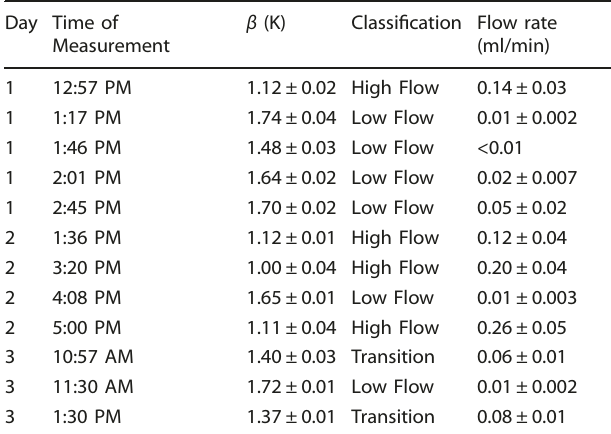
Table 1. Flow rates calculated for 12 spot check measurements on healthy out-patient (M,21) across 3-day period, with values of β for classi fi cation into high ( β < 1.3 K green), low ( β > 1.3 K, red ) and transition ( β ~ 1.3 K blue) fl ow regimes.